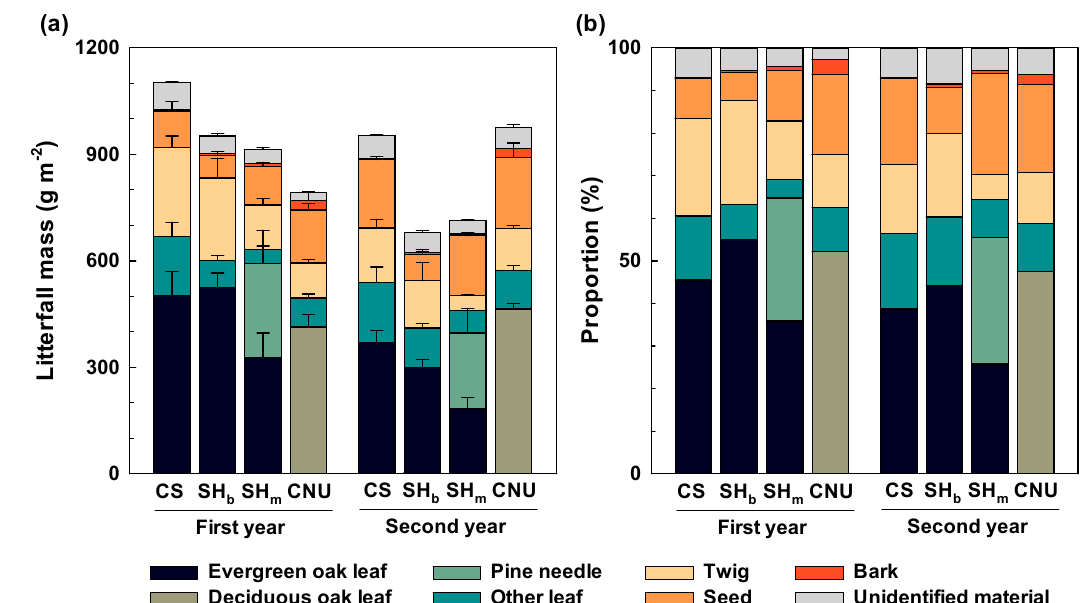
Figure 2. Annual litterfall ( a ) mass and ( b ) proportion of each litter component in evergreen broadleaved forest at Cheongsu (CS), evergreen broadleaved forest at Seonheul (SH b ), mixed forest at Seonheul (SH m ), and deciduous broadleaved forest at Chungnam National University (CNU) from August 2016 to August 2018. First and second year indicate the period from August 19, 2016 to August 23, 2017 and from August 24, 2017 to August 21, 2018, respectively. Evergreen oak leaf includes Quercus glauca and Q. salicina in CS, SH b , and SH m . Pine needle in SH m represents needle litter of Pinus thunbergii . Deciduous oak leaf in CNU represents leaf litter of Q. acutissima . Table 2. P values estimated by two-way analysis of variance (ANOVA) for seasonal litterfall variation Total and each litter component were significantly different across stands and seasons (Table 2). across stands in Jeju Island and Daejeon of South Korea.